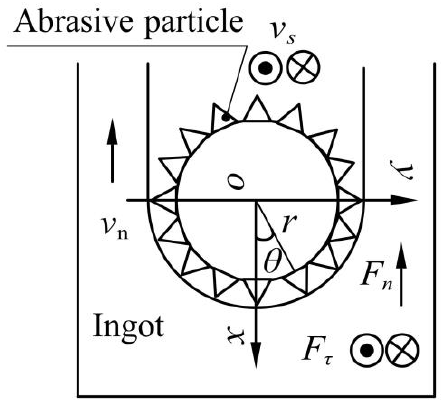
Figure 4. Schematic diagram of the wire cross-section.